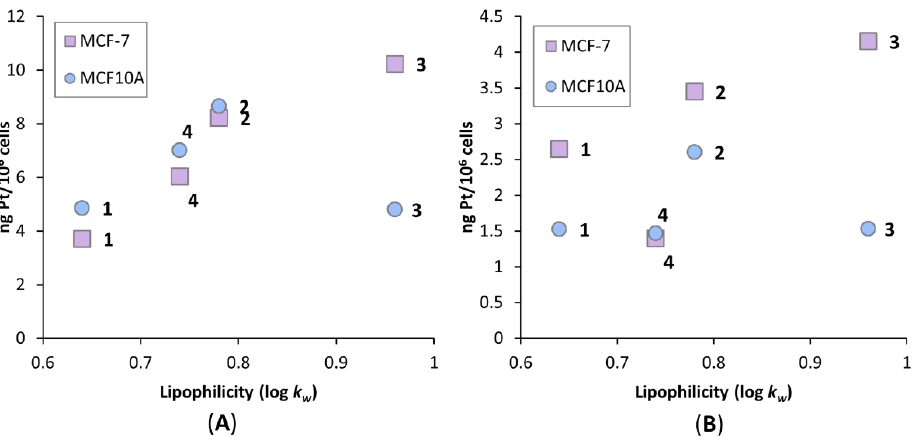
Figure 12. Correlation between the lipophilicity and cellular accumulation of 1 – 4 in MCF-7 (breast cancer) and MCF10A (healthy breast) cell lines. Lipophilicity values are reported as log k w values and cellular accumulation levels are reported as ng Pt/10 6 cells, produced from three independent experiments. For cellular accumulation experiments, cells were treated for 4 h, at 1.0 µM ( A ) and 0.1 µM ( B ) concentrations.